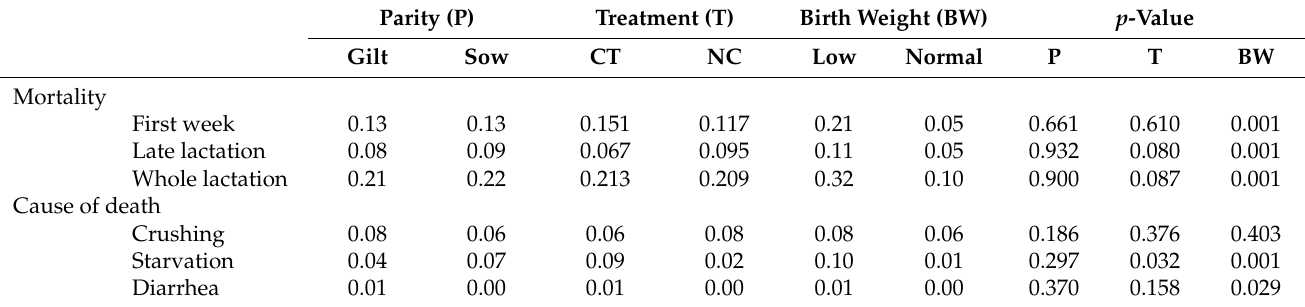
Table 1. Effect of parity (P), neonatal care treatment (T), and birth weight (BW) on preweaning mortality and causes of death of piglets and chi-square comparison in ratio of mortality (CT: control; NC: neonatal care; low BW: weight equal to or less than 1.1 kg; normal BW: weight over 1.1 kg). Parity (P) Birth Weight